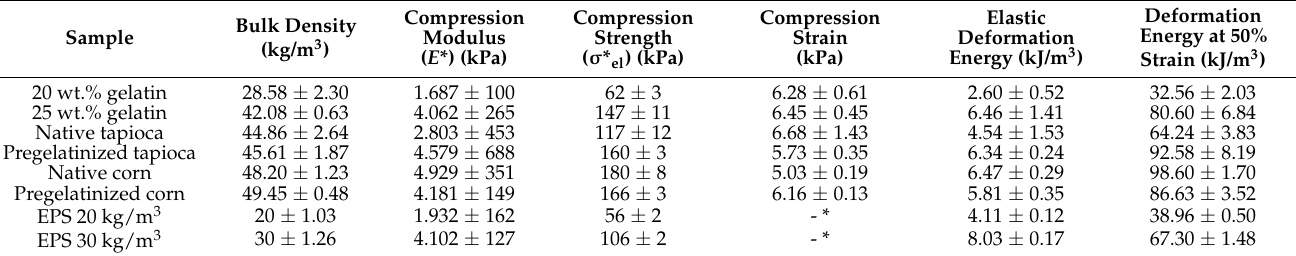
Table 7. Compression properties of gelatin, gelatin starch and EPS